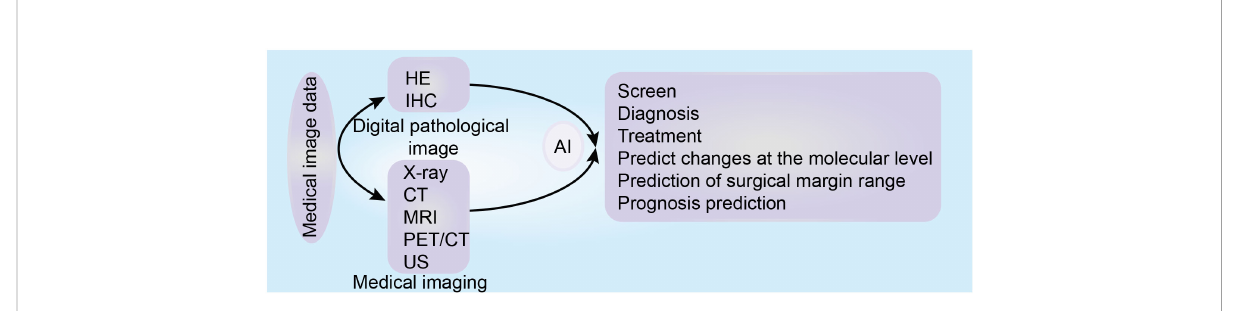
FIGURE 4 The role of arti fi cial intelligence based on medical images (digital pathological image and medical imaging) in tumor precision